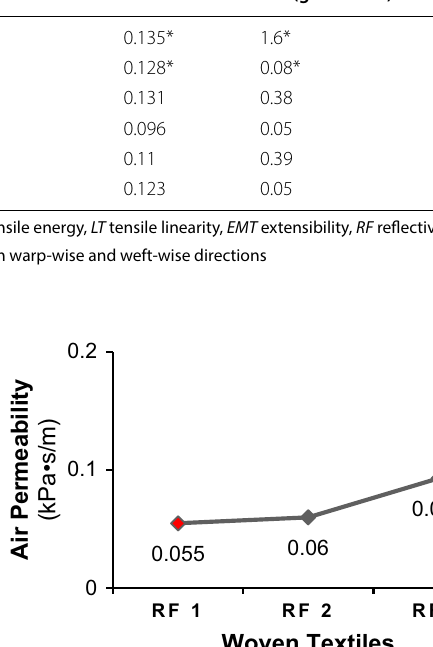
Table 2 Tensile properties of samples in this study Sample